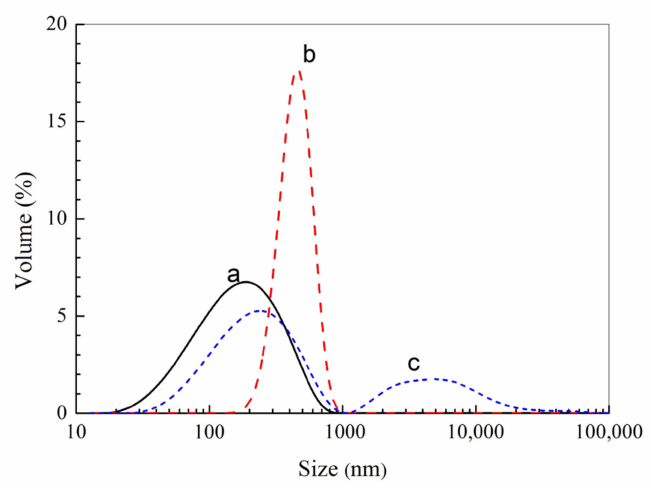
Figure 3. Size distribution of haa-MIP and NIP. ( a ) haa-MIP in acetonitrile. ( b ) NIP in acetonitrile. ( c ) haa-MIP in water.